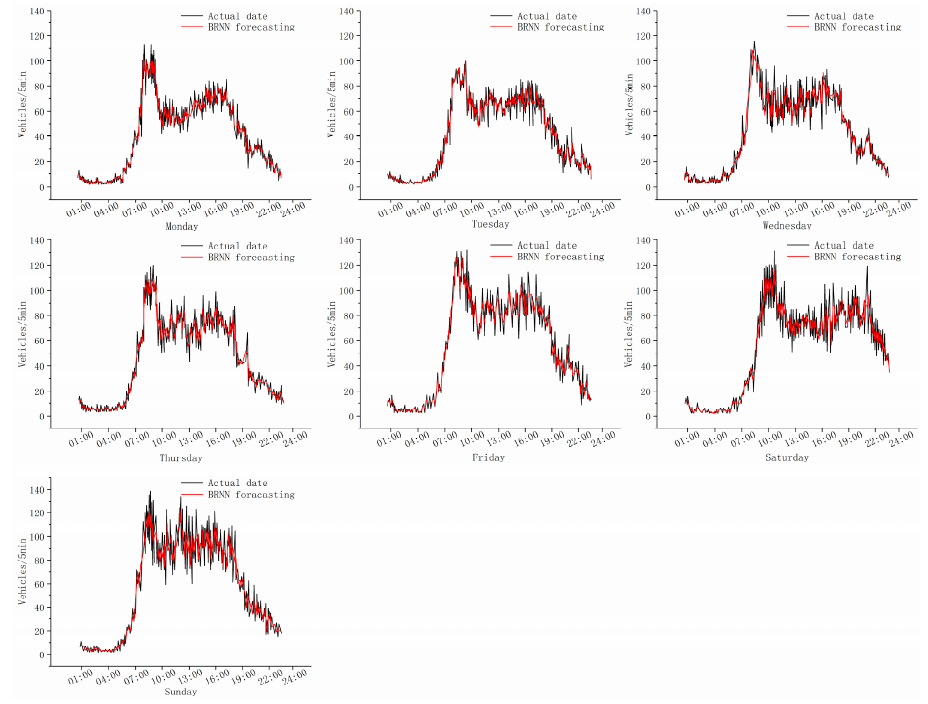
Figure 9. The comparison results of predicted and real traffic flow in a week's time.